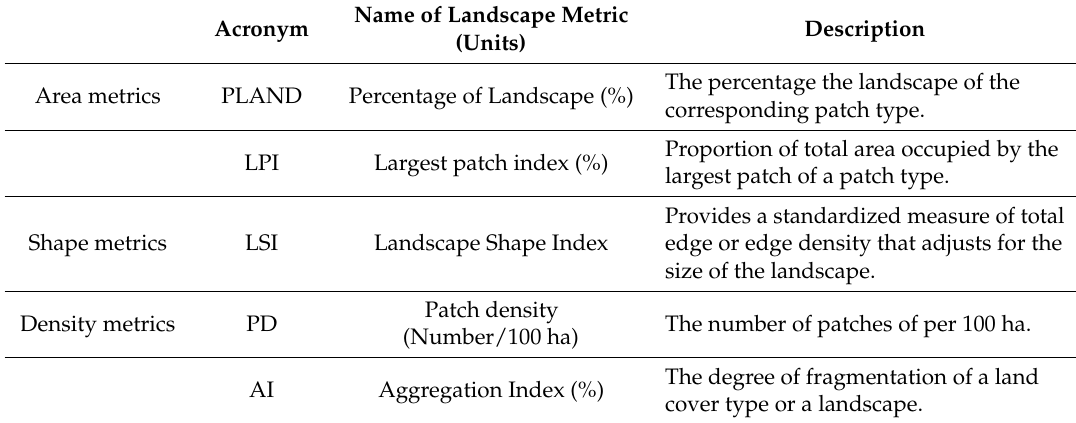
Table 3. Landscape metrics used in this study.